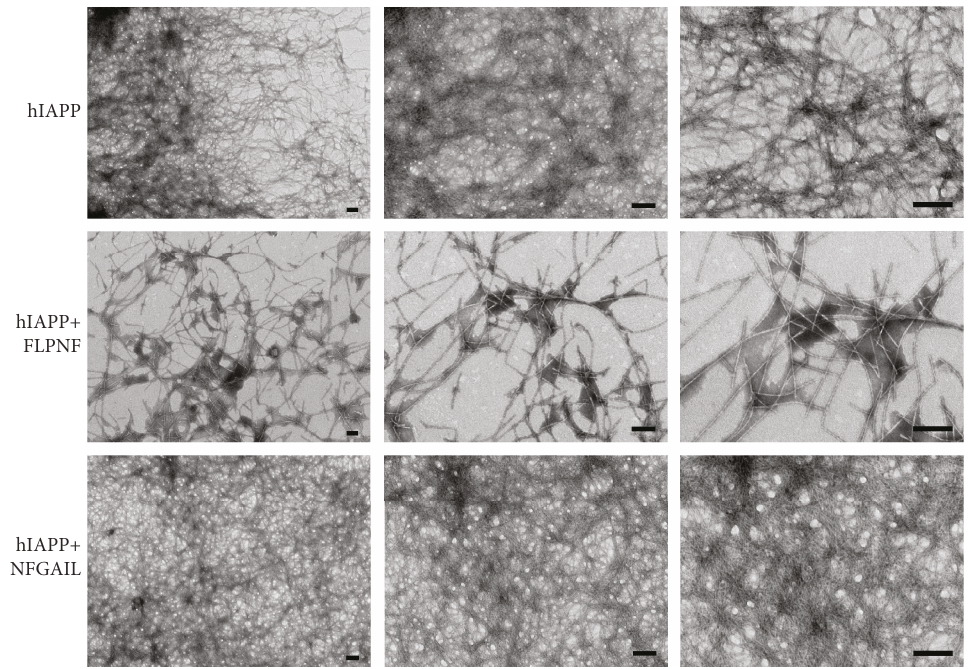
Figure 4: Observation of morphology of hIAPP fi bril formation by a transmission electron microscope (TEM). The electron micrographs were taken following incubation for 24 hours at 37 ° C. The concentration of hIAPP was 10 μ M while the concentrations of FLPNF and NFGAIL were 100 μ M. Full-length hIAPP fi brils showing typical morphology and formation of dense aggregates. The fi brils of hIAPP incubated with FLPNF were not completely prevented but were reduced in density. No reduction of the fi brils was observed after adding NFGAIL. Scale bar: 200 nm.